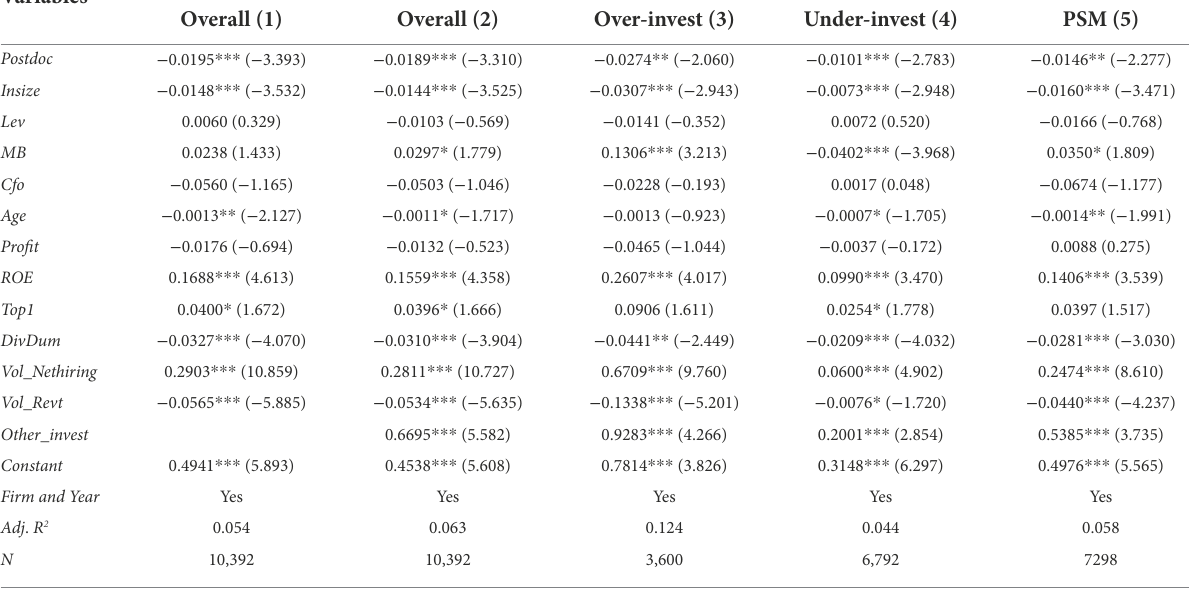
TABLE 4 The effect of postdoctoral workstation on LIE.